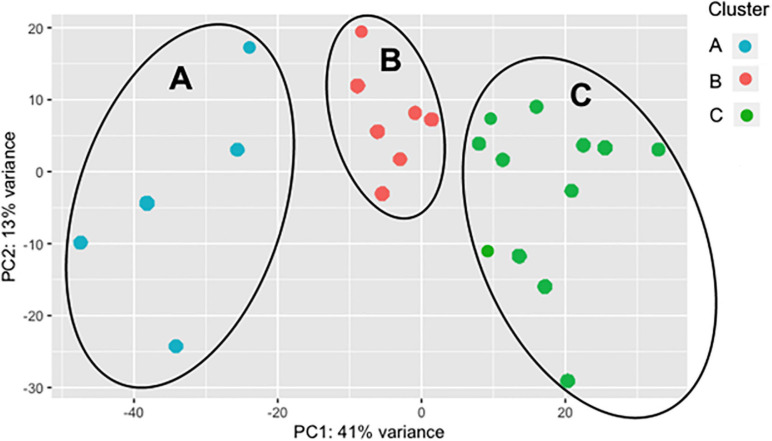
Principal component analysis (PCA) displaying clustering of bovine respiratory disease (BRD) samples. Cluster dendrogram identifying groups in the BRD population (n = 25) that are similar to one another based on gene expression. The BRD data is further subdivided into three distinct clusters.